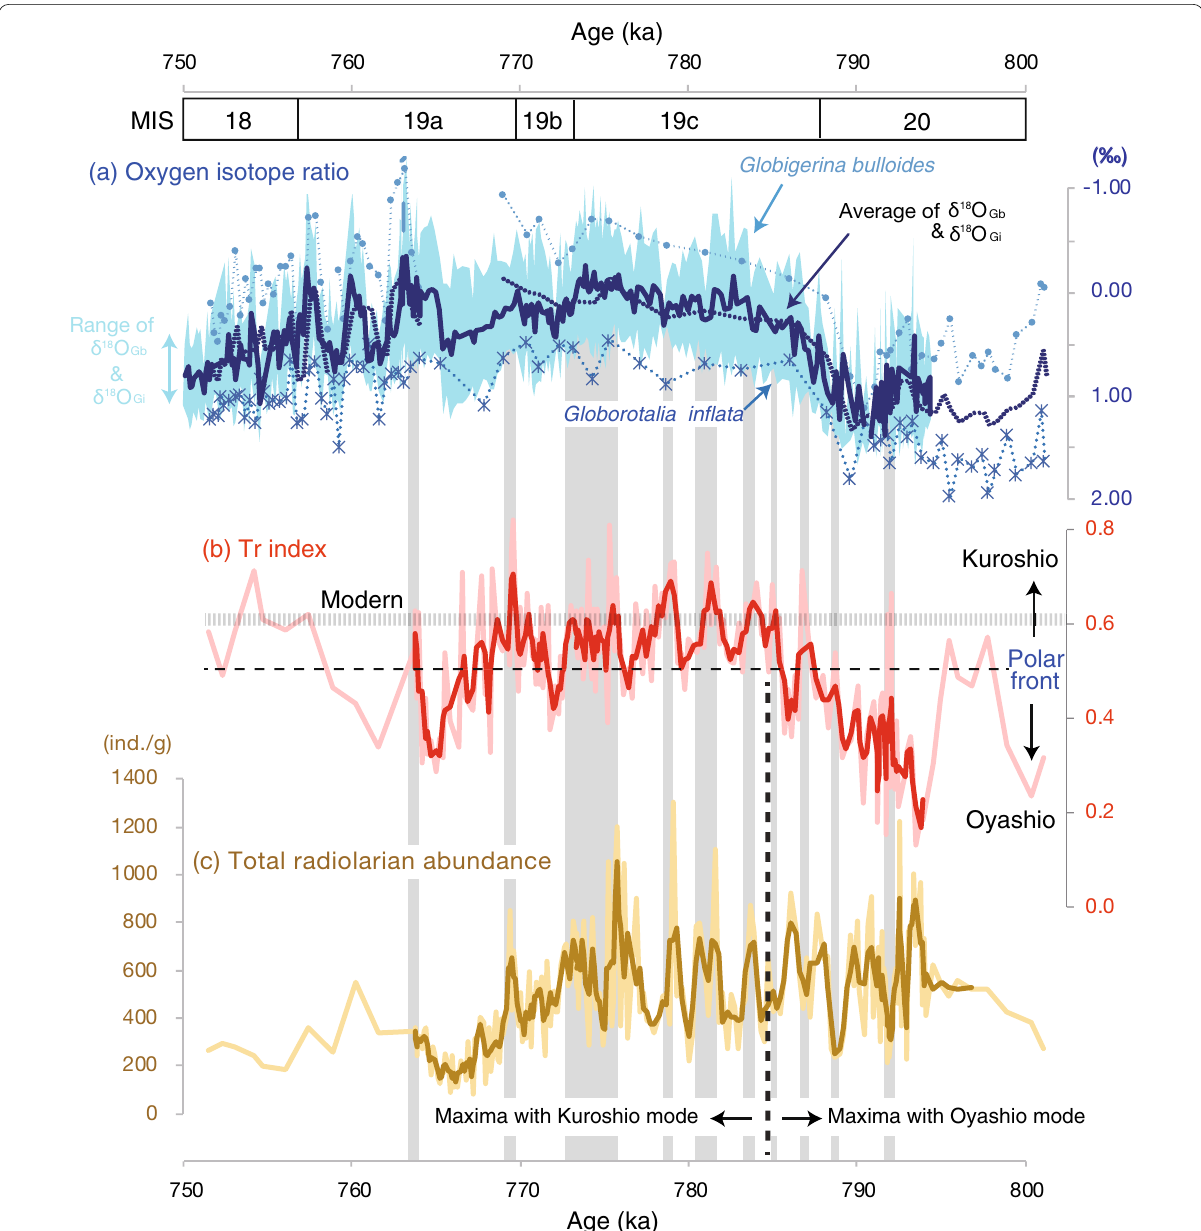
Fig. 4 Comparisons among paleoceanographic proxies: a Oxygen isotope record (δ 18 O) of planktonic and benthic foraminifera (Haneda et al. 2020). Pale blue indicates the range of values for Globigerina bulloides (δ 18 O Gb , upper limit) and Globorotalia inflata (δ 18 O Gi , lower limit) from the Yoro River and Yoro-Tabuchi sections. Dark blue solid line indicates average of δ 18 O Gb and δ 18 O Gi . Dashed lines with solid circles and indicate δ 18 O Gb and δ 18 O Gi from the Kokusabata, Yanagawa and Urajiro sections, and the dark-blue dashed line without dots shows their average. b Variations of the Tr index. Pale red line indicates original plots, and their three-point moving average is shown as a red line for the high-resolution interval. c Total radiolarian abundance changes. Yellow line shows the original plots and the dark line indicates moving average over three points. Gray bands indicate intervals of multiple maxima of the Tr curve for the high-resolution